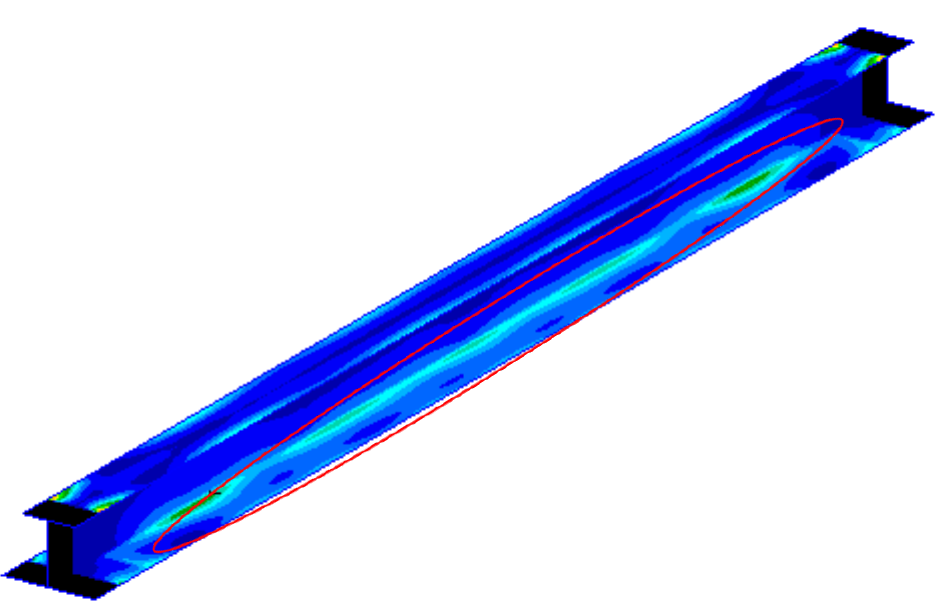
Figure 8. The typical strain energy of the composite I-shape beam.